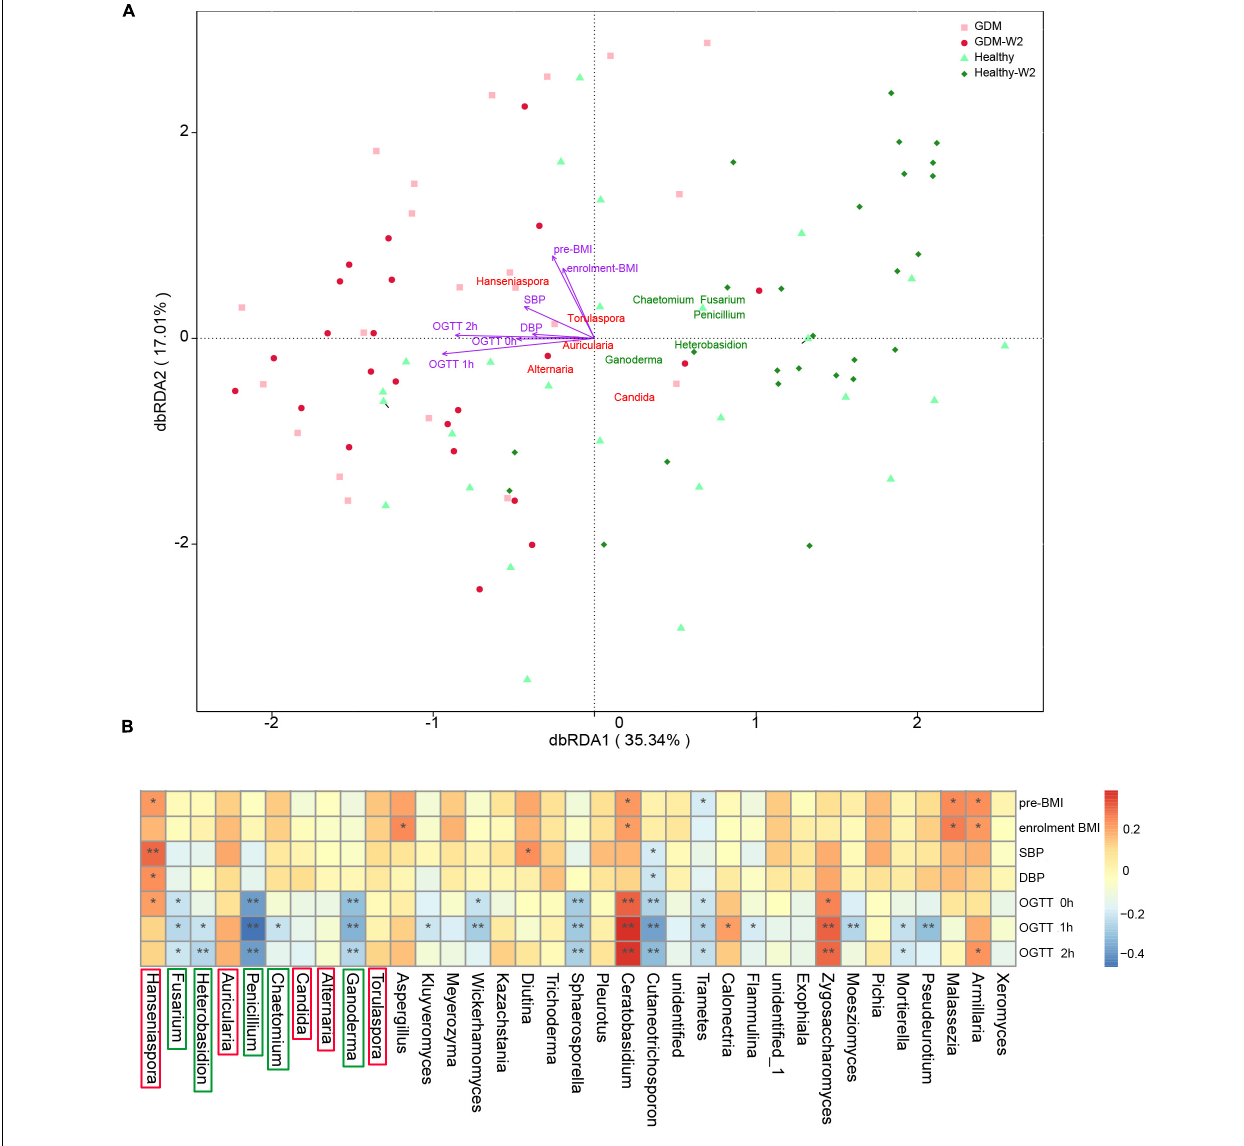
FIGURE 3 | (A) Key contributors to fungal community variation was determined by RDA analysis, plotted on the two first RDA dimensions. (B) Heatmap analysis of the correlation between the gut mycobiome composition and clinical parameters, ** P < 0.01, * P <